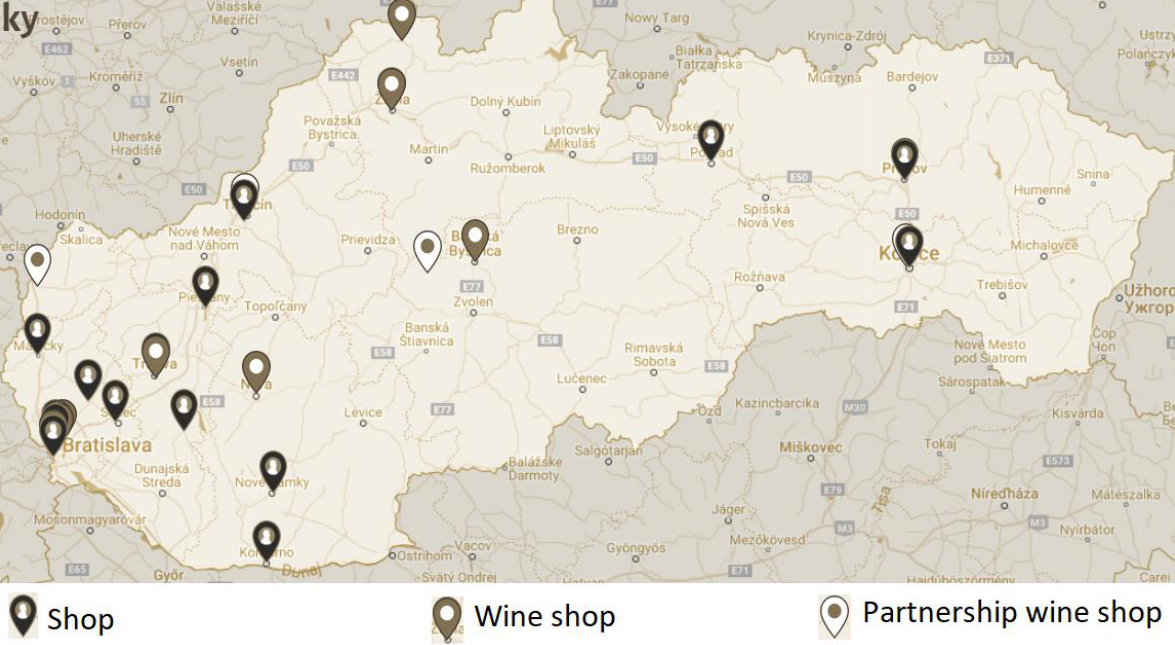
Figure 1. Shops, wine shops, and partnership wine shops of Company V in Slovakia [55].